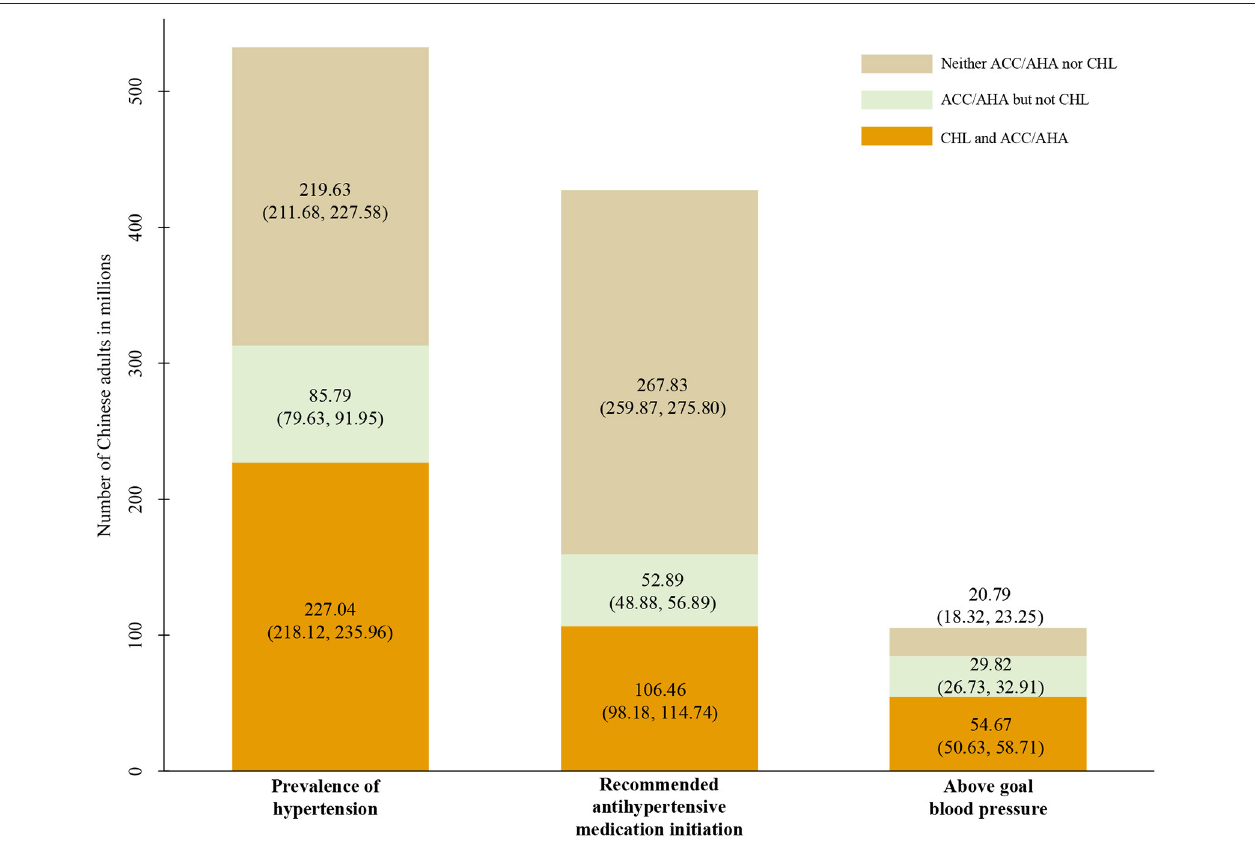
FIGURE 2 | Number of hypertension cases, recommended to initiate antihypertensive medication, above the goal blood pressure. Data used for estimating were collected from CHARLS 2011–2012 baseline survey.